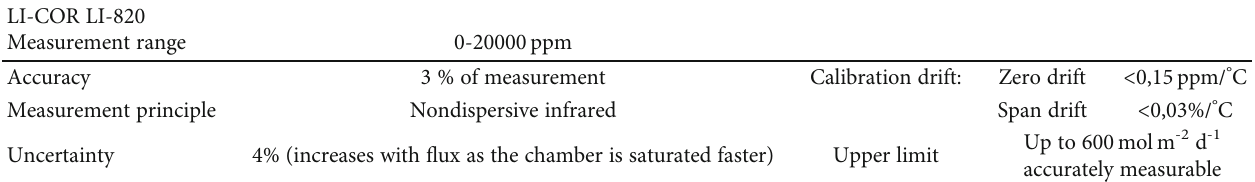
Table 2: Technical data LICOR LI-820 (LI-COR, uncertainty and upper limit from [28] and the manufacturer ’ s manual).